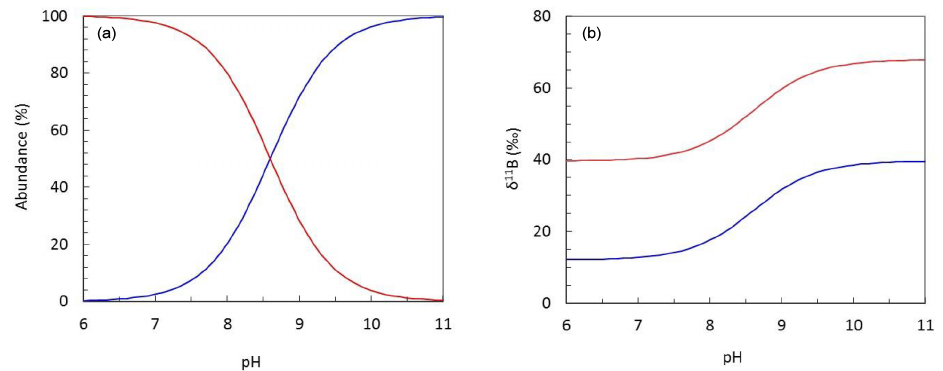
Figure 6. Plots describing (a) the pH-dependent relationship between the abundance of aqueous boron species and (b) the isotopic fraction- ation observed between boric acid (B ( OH ) 3 ; red) and borate (B ( OH ) −